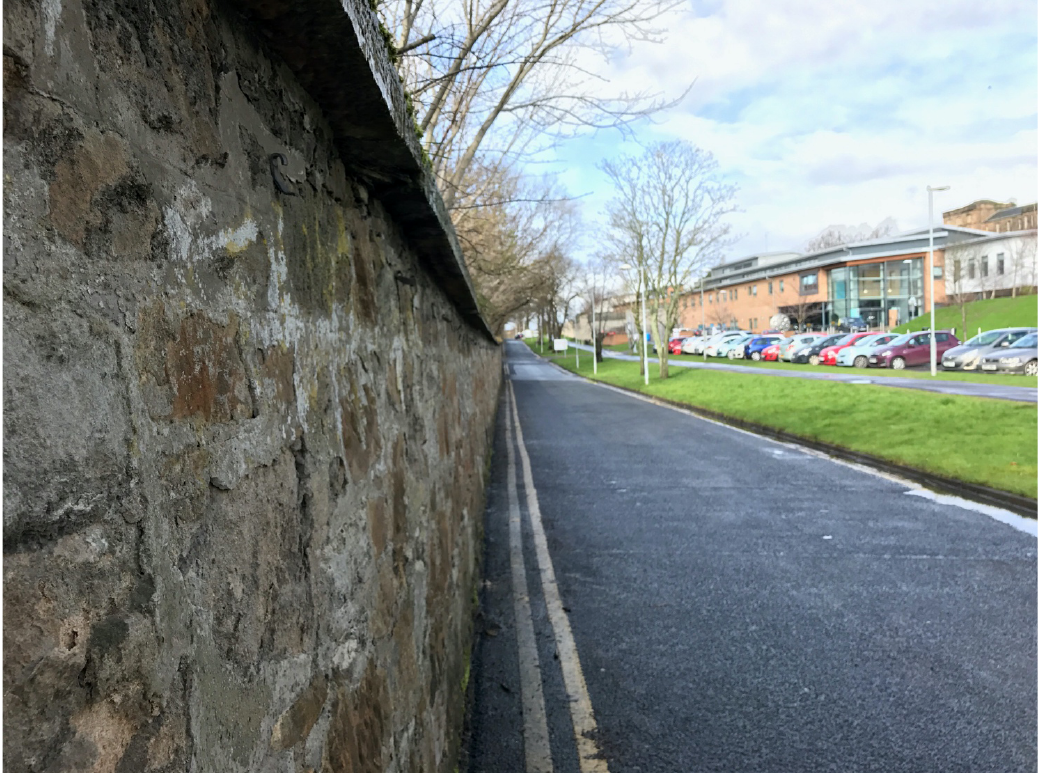
Figure 5. Perimeter wall and the new psychiatric facility at Gartnavel, designed by Macmon architects. Source: Ebba